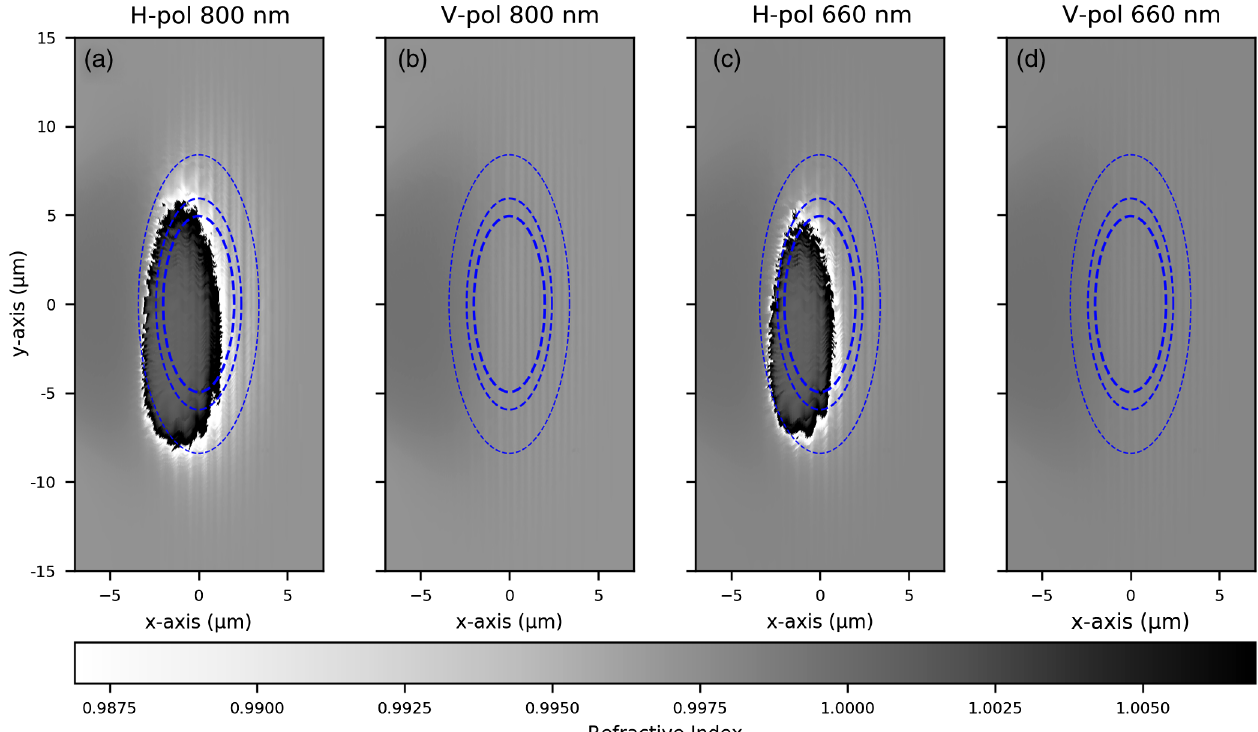
FIG. 7. Refractive index of the plasma in the xy plane for different probe polarizations and wavelengths induced by a pump pulse with 15.7 fs FWHM duration and an a 0 of 3.5. The blue, dashed lines represent the FWHM, 1 = e and 1 = e 2 intensity contours of the Gaussian pump pulse. Each subplot of the figure is labeled with the probe beam ’ s polarization (H-pol or V-pol) and its wavelength (800 or 660 nm). The figures are calculated from data produced from VS im in simulating the xy